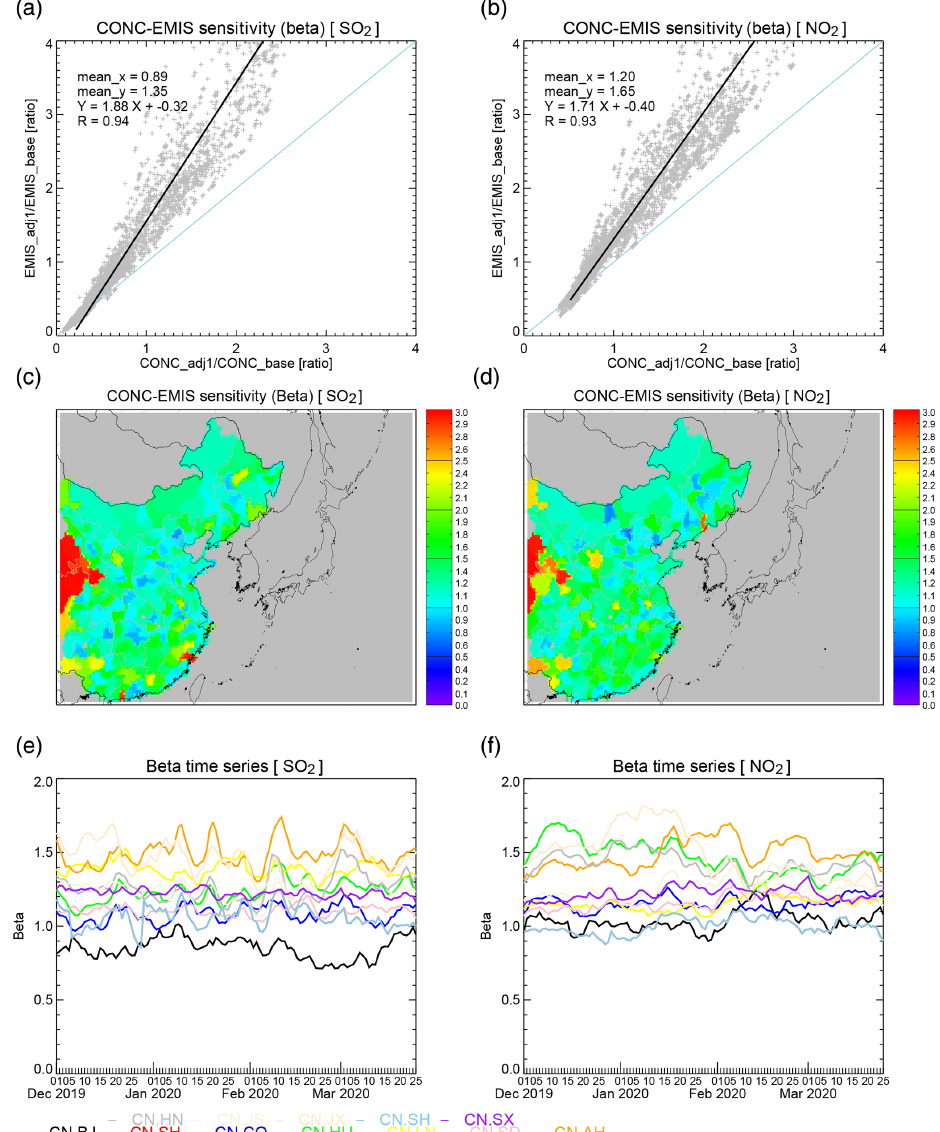
Figure 8. Calculation of the concentration-to-emissions sensitivities ( β ) for the emission adjustment experiment of SO 2 (left column) and NO 2 (right column). The β values are obtained as the ratio of the emission change (i.e., Emis_adj/Emis_base) to the change in concentrations (i.e., Conc_adj1/Conc_base), which is also consistent with the slope in the scatterplot (a,b) . Spatial variations in the average concentration- to-emissions sensitivities ( β ) during January to March 2020 over China (c,d) . The temporal variations in the β values for selected Chinese provinces are shown in the lower panel (e,f) . (BJ: Beijing; SH: Shanghai; CQ: Chongqing; HU: Hubei; SD: Shandong; AH: Anhui; HN: Hunan; JS: Jiangsu; SX: